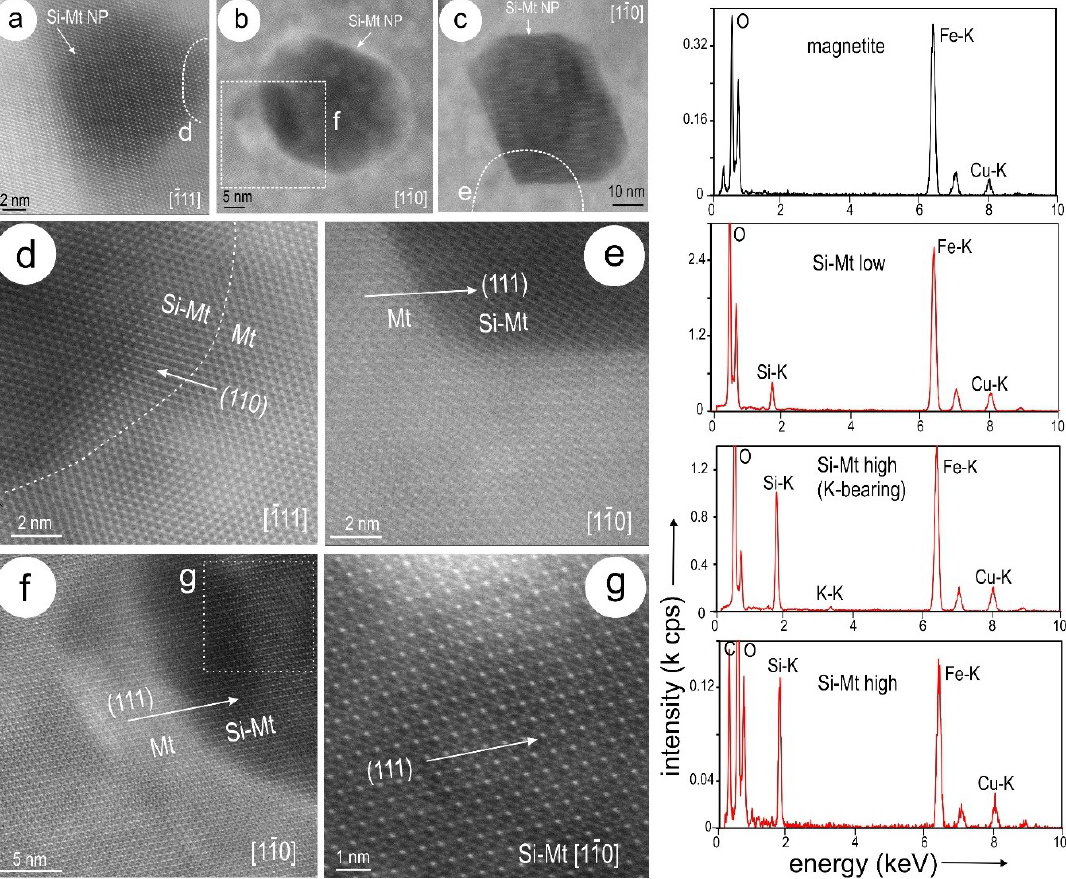
(cid:104) (cid:105) 110 zone